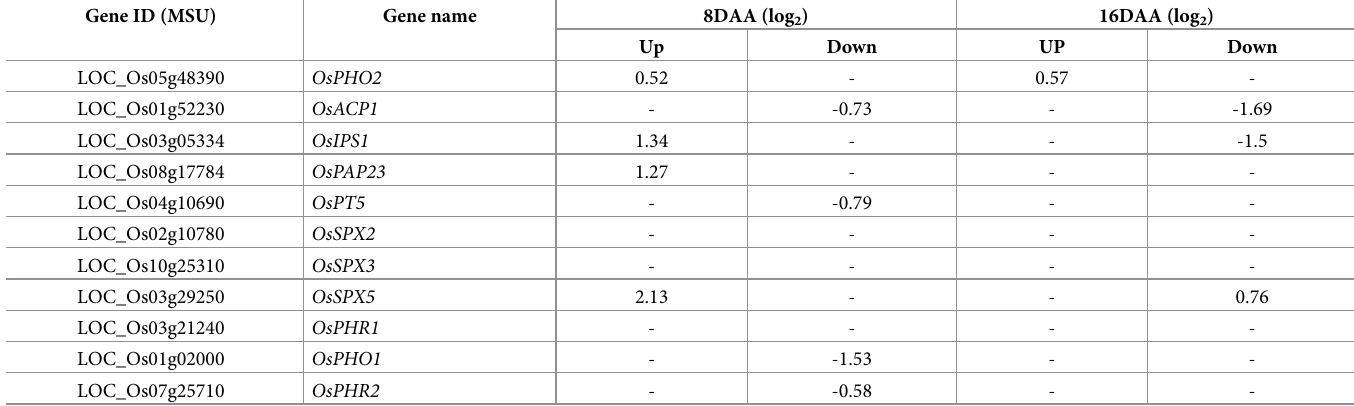
Table 1. Gene expression profile of eleven key P starvation response (PSR) genes in rice flag leaves at 8 or 16 days after anthesis, following P withdrawal from the nutrient solution 8 d earlier. Gene ID